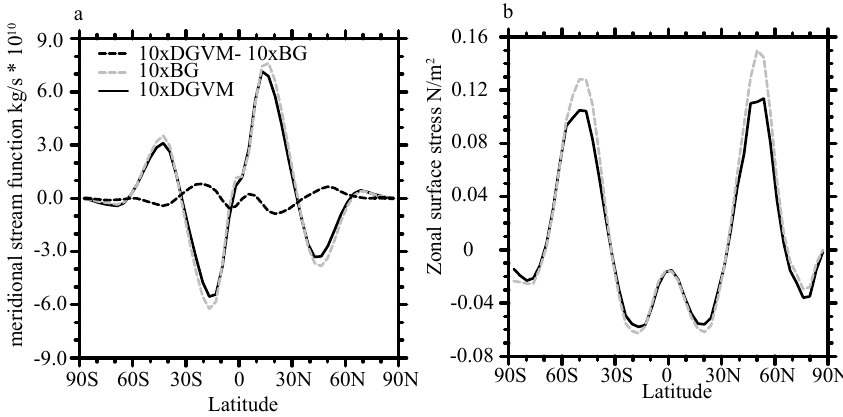
Fig. 7. Zonal-average annual mean meridional streamfunction (10 10 kgs − 1 ) at 400mb (a) ; and wind stress (Nm − 2 ) over the Pacific Ocean (b) for the 10xDGVM (black solid line), 10xBG (grey dashed line) and 10xDGVM–10xBG experiments (black dashed line), respectively. b MOC (10xBG)